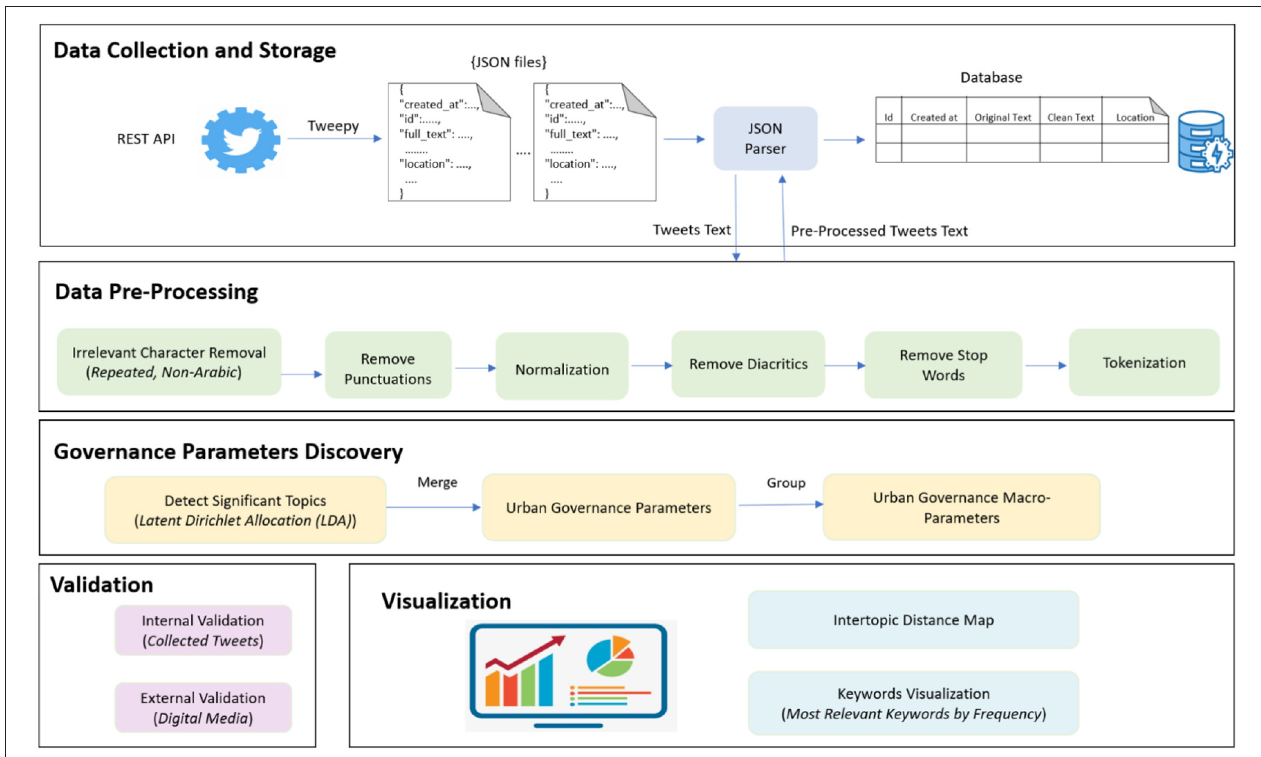
Figure 1 | The system architecture.